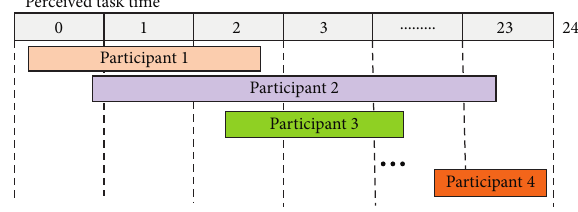
Figure 2: Task time